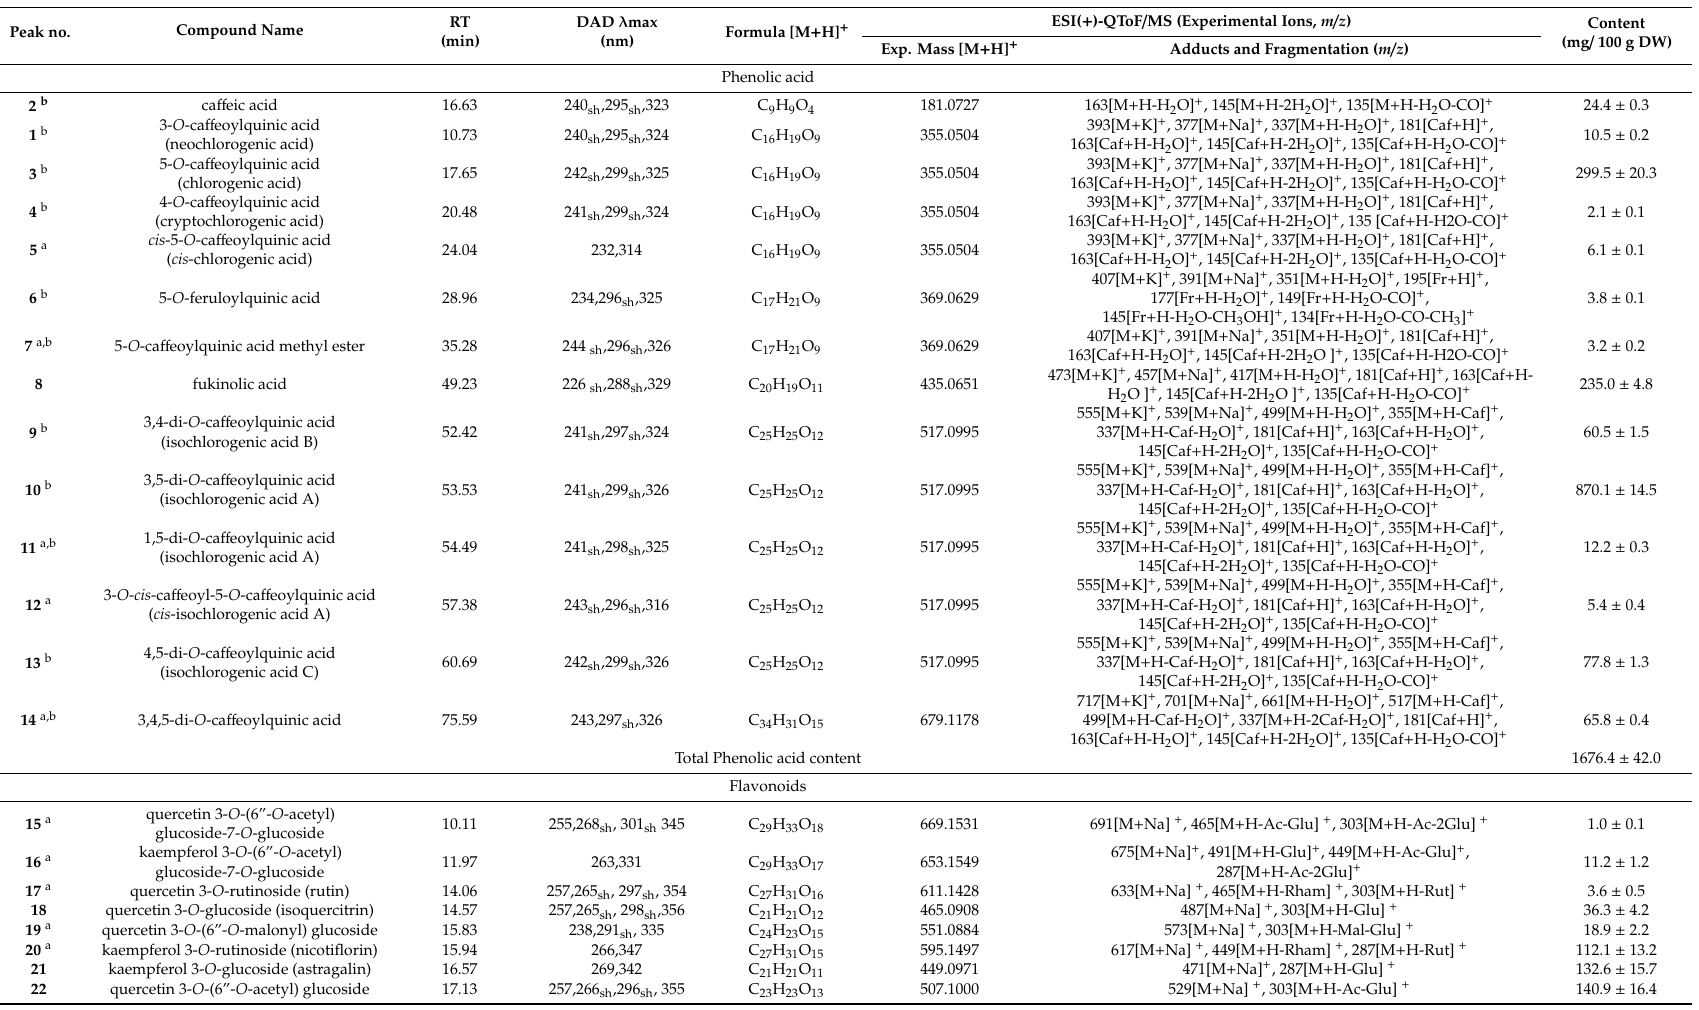
Table 1. Ultra performance liquid chromatography coupled with diode array detector, quadrupole time-of-flight mass spectrometry (UPLC-QToF-MS) characterization and contents of polyphenolic compounds from